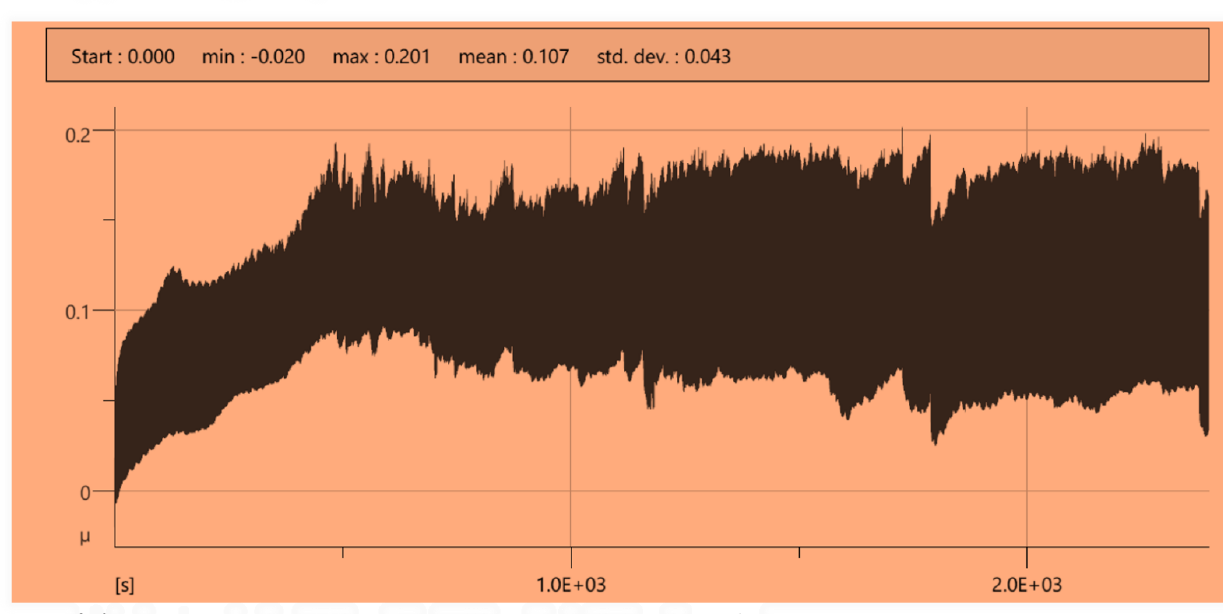
Figure 6. ( a , b ) compare the graph of the coefficient of friction versus time of CuNbTiB 2 C alloys with nano and micron both sintered at 650 °C.